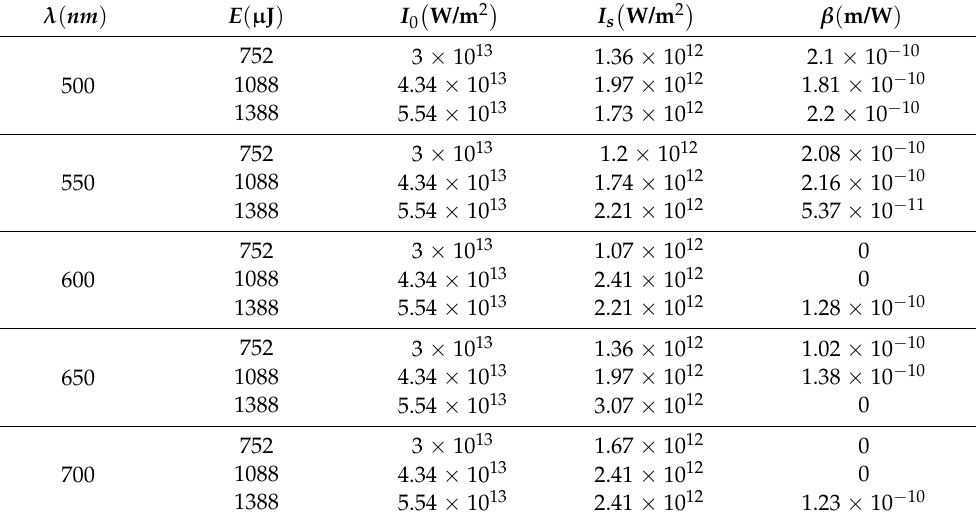
Table 1. Nonlinear Optical Parameters of PtNPs.